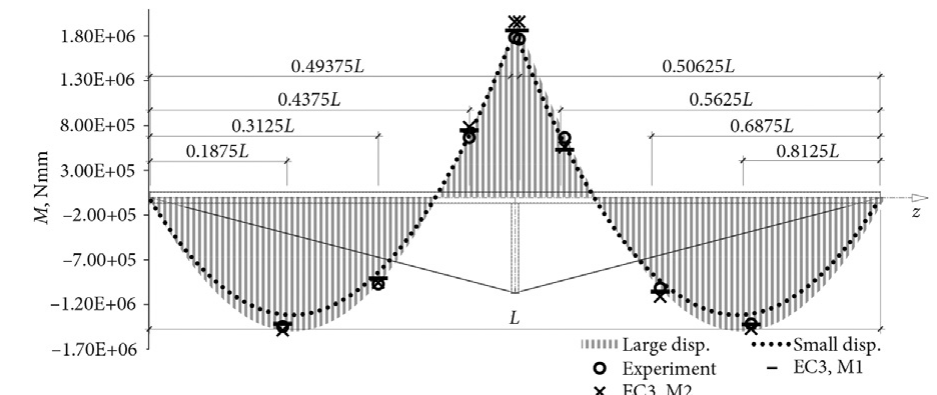
Fig. 6. Results of the UGB flexural response under Test